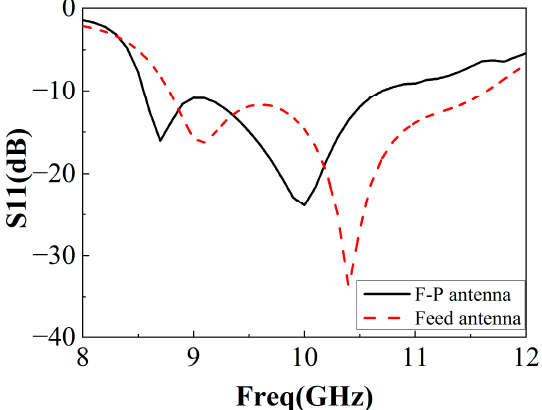
Figure 14. Reflection coefficient of F-P antenna and feed antenna.